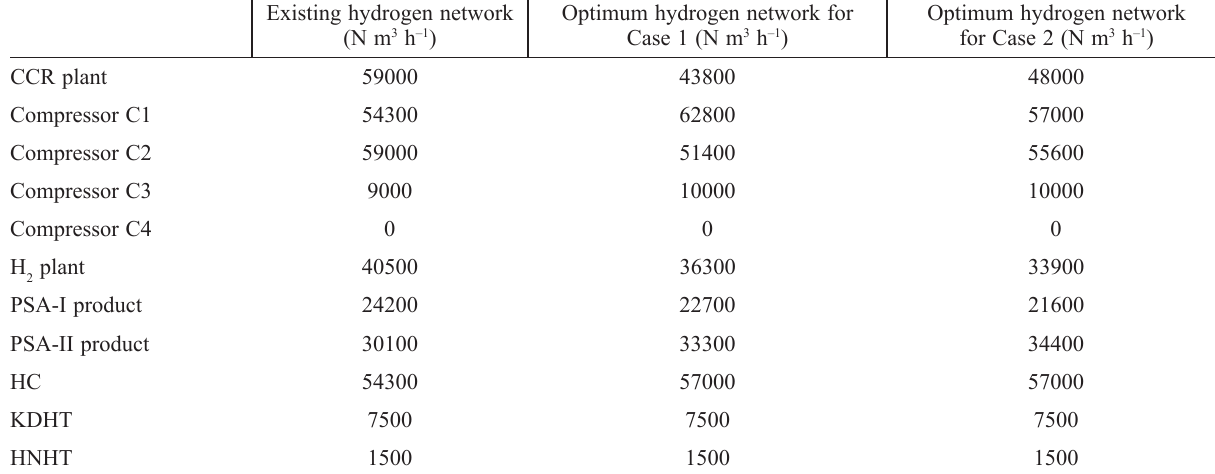
Table 8 – Optimal results for Case